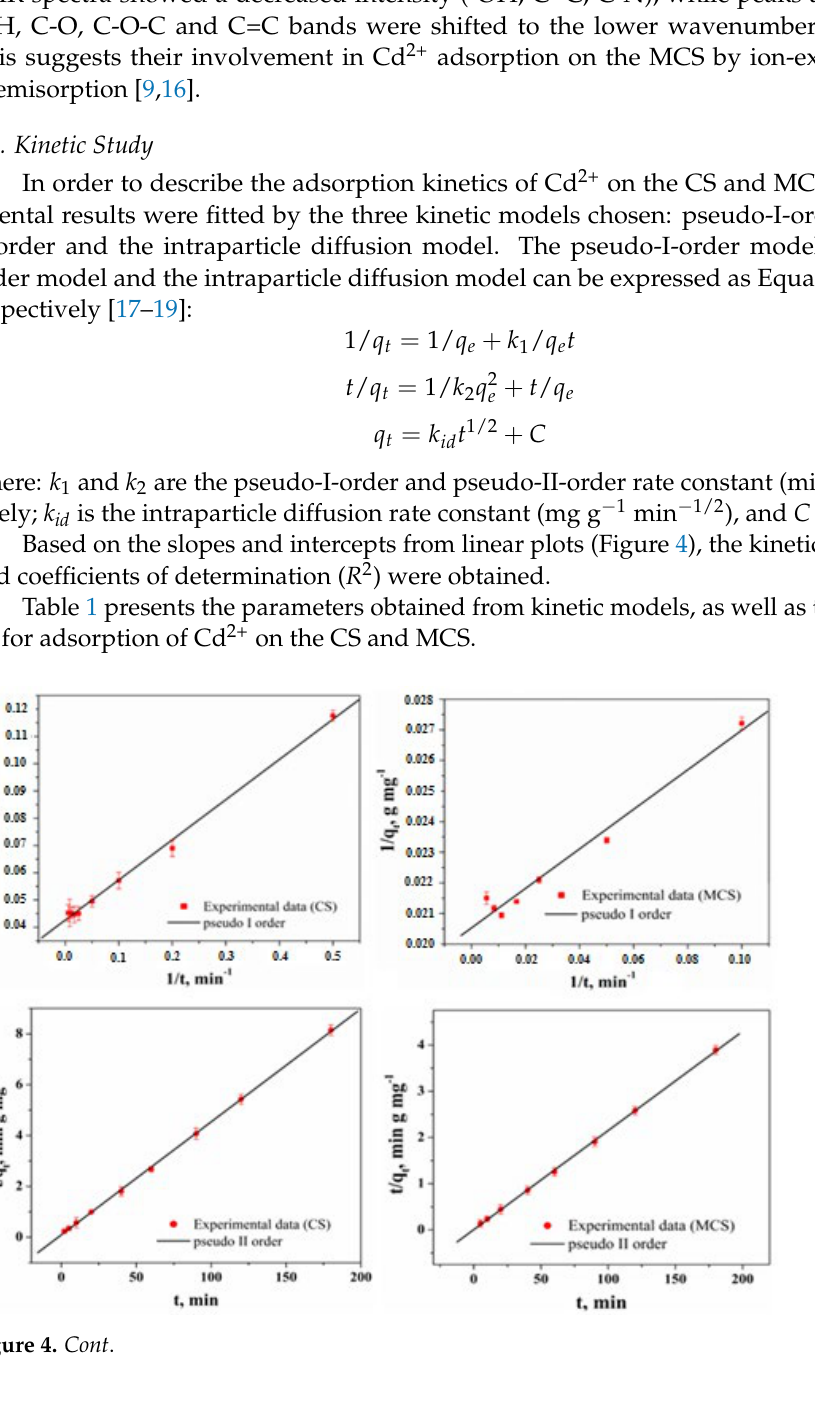
Figure 4. Kinetic models for Cd 2+ adsorption on the CS and MCS. Table 1. Kinetic parameters for Cd 2+ adsorption on the CS and MCS. Kinetics Model